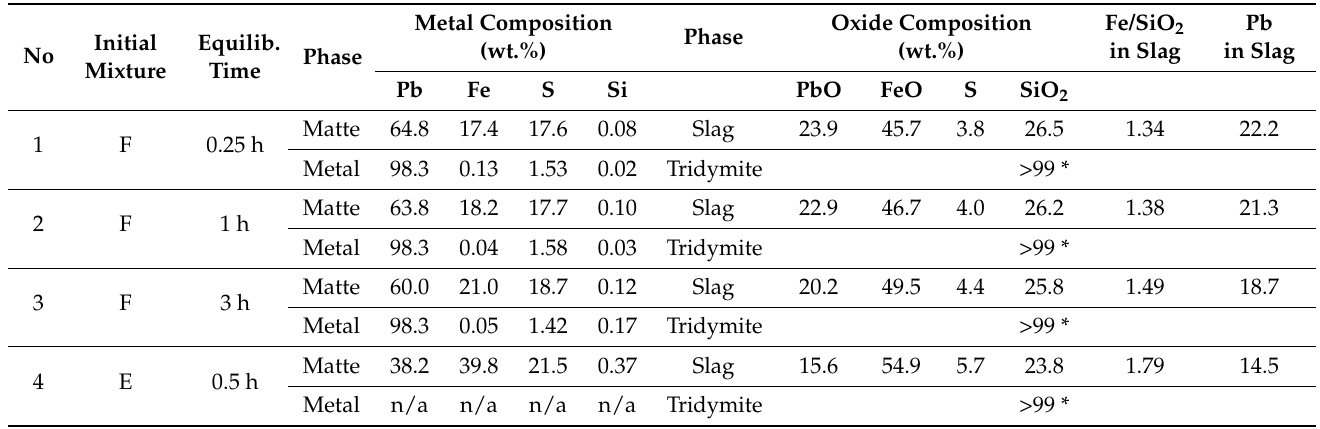
Table 3. Measured phase compositions for the closed slag–matte-Pb metal–tridymite Pb-Fe-O-S-Si system at 1200 ◦ C with master matte and master slag as starting materials.